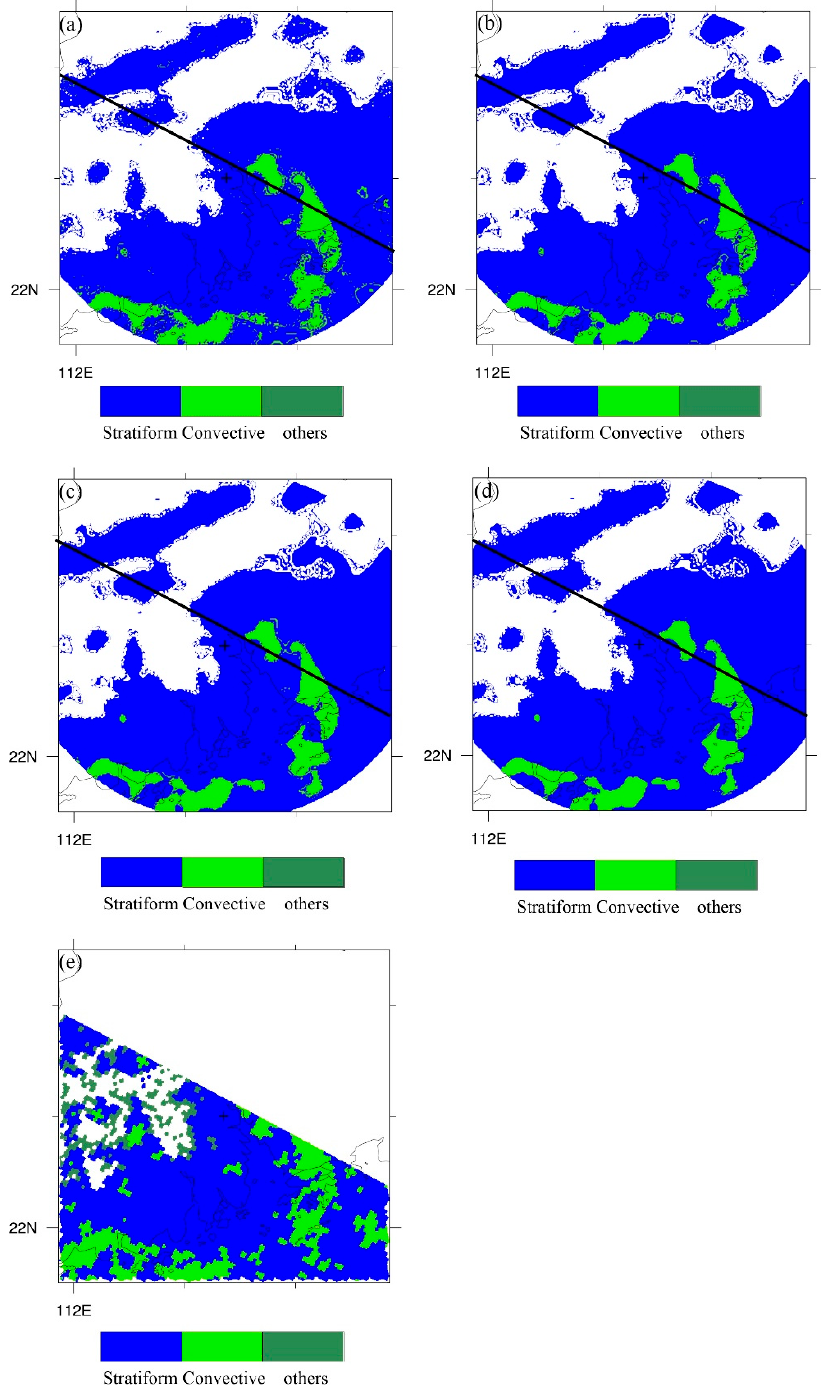
Figure 2. A case from Guangzhou at 05:28 (UTC) on 6 June, 2008, shows the classification results for di ff erent k values. ( a – d ) are the results for k = 5, 10, 15, and 20, and ( e ) is the classification of the 2A23 product. The bold black line represents the boundary of the PR scan